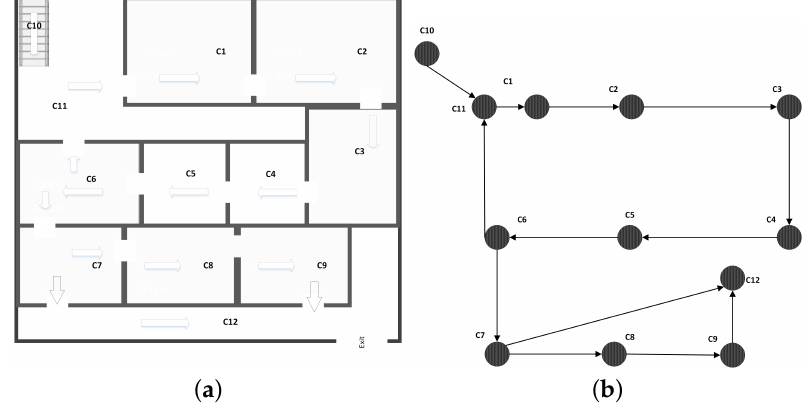
Figure 6. Directed graph for the building. ( a ) An example of a directed floor; ( b ) directed indoor